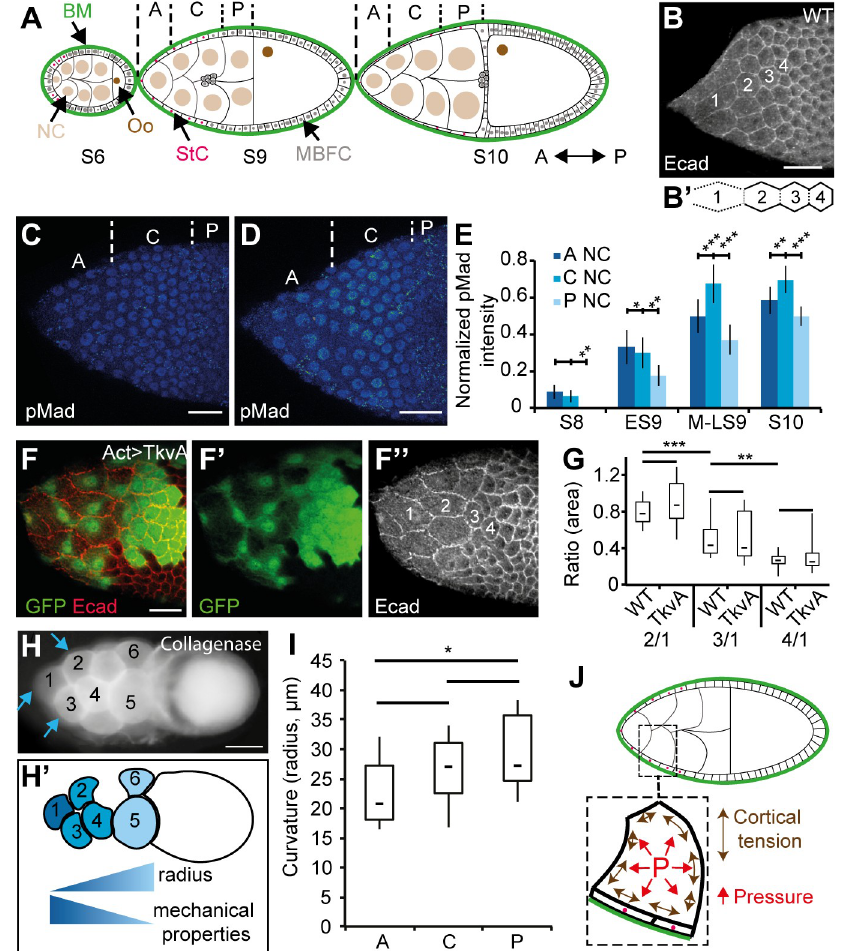
Fig 1. An A/P gradient of mechanical properties is present in the NCs. In all figures, anterior is to the left. (A) Schematic representation of three follicles at different developmental stages (S6, S9, and S10) with NCs, Oo, MBFCs, StCs, and BM indicated. From S8 onward, NCs are grouped into three regions for analysis: anterior (“A”), central (“C”), and the four posterior (“P”) NCs. (B) AJs (Ecad) remodeling and increase of apical surface occur in the StC of an S9 follicle. Both variables are marker of flattening (see S1 Movie). Four cells are labeled from anterior (“1”) to posterior (“4”) to highlight changes in apical surface. (B’) Schematic representation of AJ remodeling, with dotted lines representing remodeled AJ and solid lines representing intact AJ. The AJ disassembly consists of first remodeling the vertices on the same row and the AJ perpendicular to the A/P axis; second, elongating the AJ parallel to the AP axis; and third, disassembling those AJ (Fig 1B’). (C, D) pMad expression in early (C) and mid (D) WT S9 follicles. The anterior (“A”), central (“C”), and posterior (“P”) regions of the NC are indicated. (E) Quantification of pMad in follicular cells during StC flattening ( n > 15 nuclei per condition). (F) TkvA-expressing StC in an S9 follicle marked by GFP (F and F’), and with StC labeled in increasing order from anterior to posterior (F”). (G) Box and whisker plot of the ratio of surface area of StC in WT or TkvA-expressing StC at the different positions shown in (B) or (F”), respectively ( n > 23 cells per plot). (H) A WT S10 follicle after collagenase treatment, showing the NC bulging outward, with the corresponding schematic representation of the mechanical property gradient based on NC membrane curvature (the measured curvature corresponds to the membrane bulging outwards). Blue arrows point to the region of the membrane used to calculate the curvature (H’). (I) Box and whisker plot of the radius of curvature of anterior (“A”), central (“C”), or posterior (“P”) NC ( n > 13 per region) in LS9 and S10 follicles. (J) Schematic representation of an S9 follicle, with a blow up on an NC, its overlying StC, and the BM. In the NC, cortical tension (double-sided arrows, in brown) and cytoplasmic pressure (“P,” in red) are represented. Scale bars: 20 μ m (B-F) and 50 μ m (H). Data for graphs (E), (G), and (I) can be found in the S1 Data file. In box and whisker plots in all figures, boxes extend from 25 to 75 percentile, with a line showing the median value. Whiskers extend to the most extreme values. In all figures with panels displaying levels in fluorescence intensity, a color-coded gradient from blue (low) to red (high) is used. In all figures, error bars indicate s.e.m. In all figures, � , �� , and ��� correspond to p < 0.5, p < 0.05, and p < 0.01 ( t test), respectively. AJ, adherens junction; A/P, antero-posterior; BM, basement membrane; Ecad,